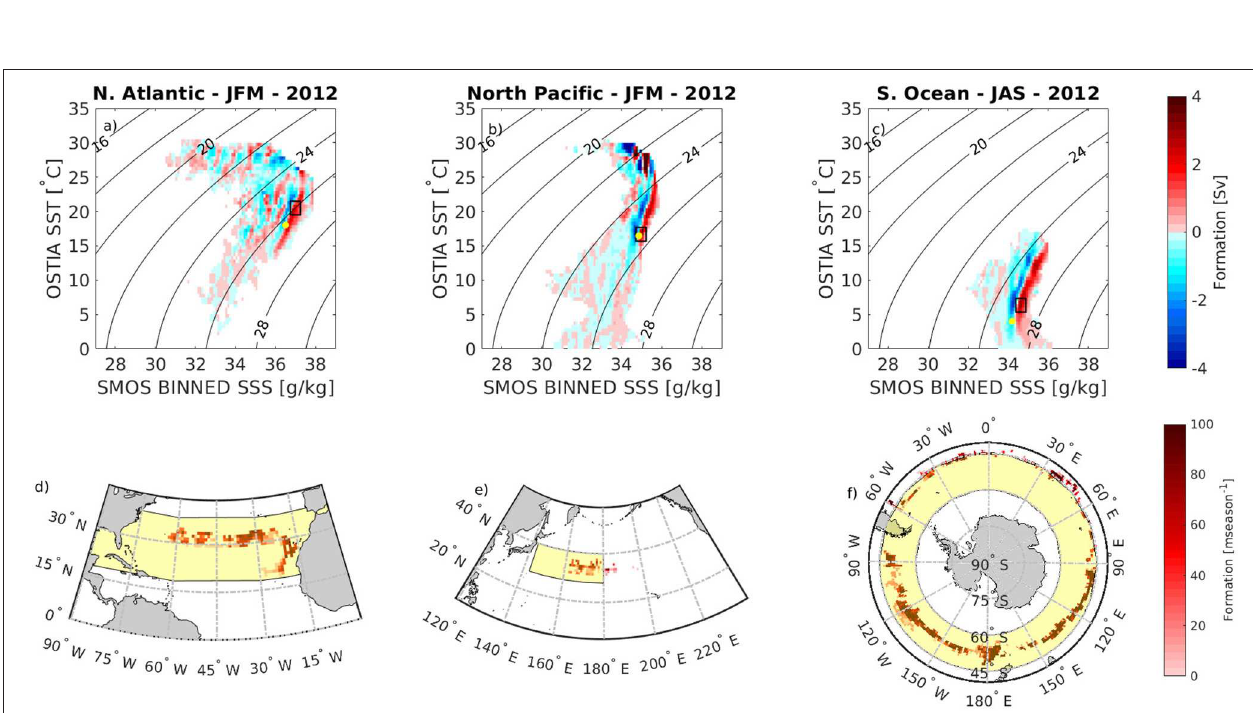
FIGURE 5 | Averaged formation over the winter season in the North Atlantic (a) , North Pacific (b) and Southern Ocean (c) . Yellow dots (a–c) indicate literature properties of Mode Water within the respective basins. Maps of positive water mass formation are shown in (d–f) with the approximate geographic literature locations shaded in yellow (Worthington, 1958; McCartney, 1977, 1982; Hanawa and Hoshino, 1988; Yasuda and Hanawa, 1997; Hanawa and Yoritaka, 2001).